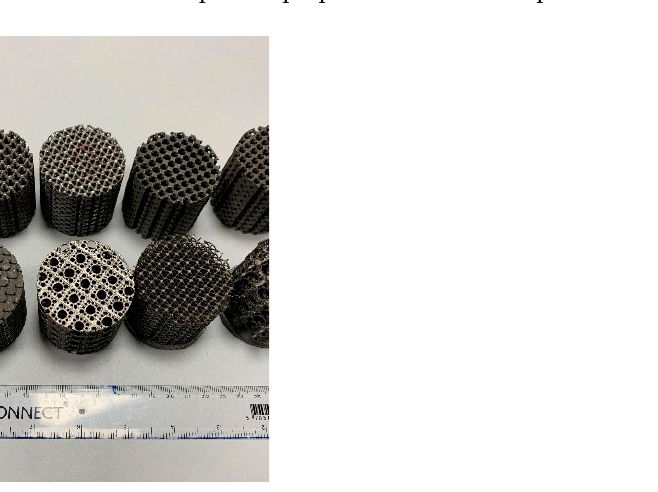
Figure 4 . Image shows cellular materials produced using the Renishaw Ren AM500 flex